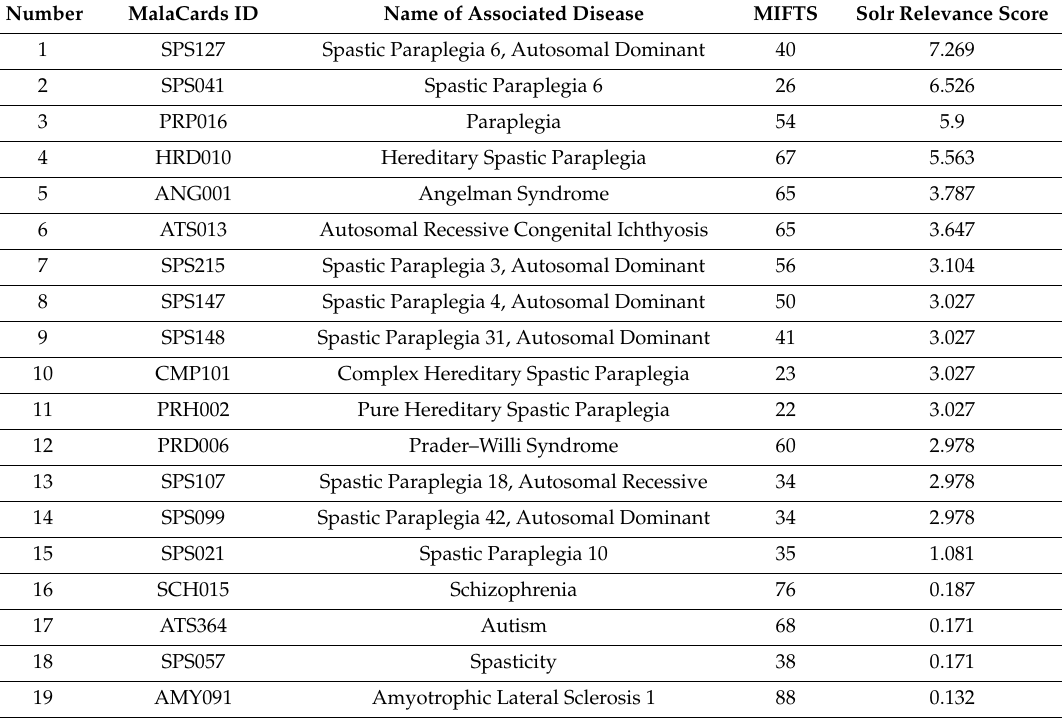
Table 4. Putative Diseases or Disorders Identifiable Using GeneCards.org, HGMD, and DISEASES as Referenced Sources for the NIPA1